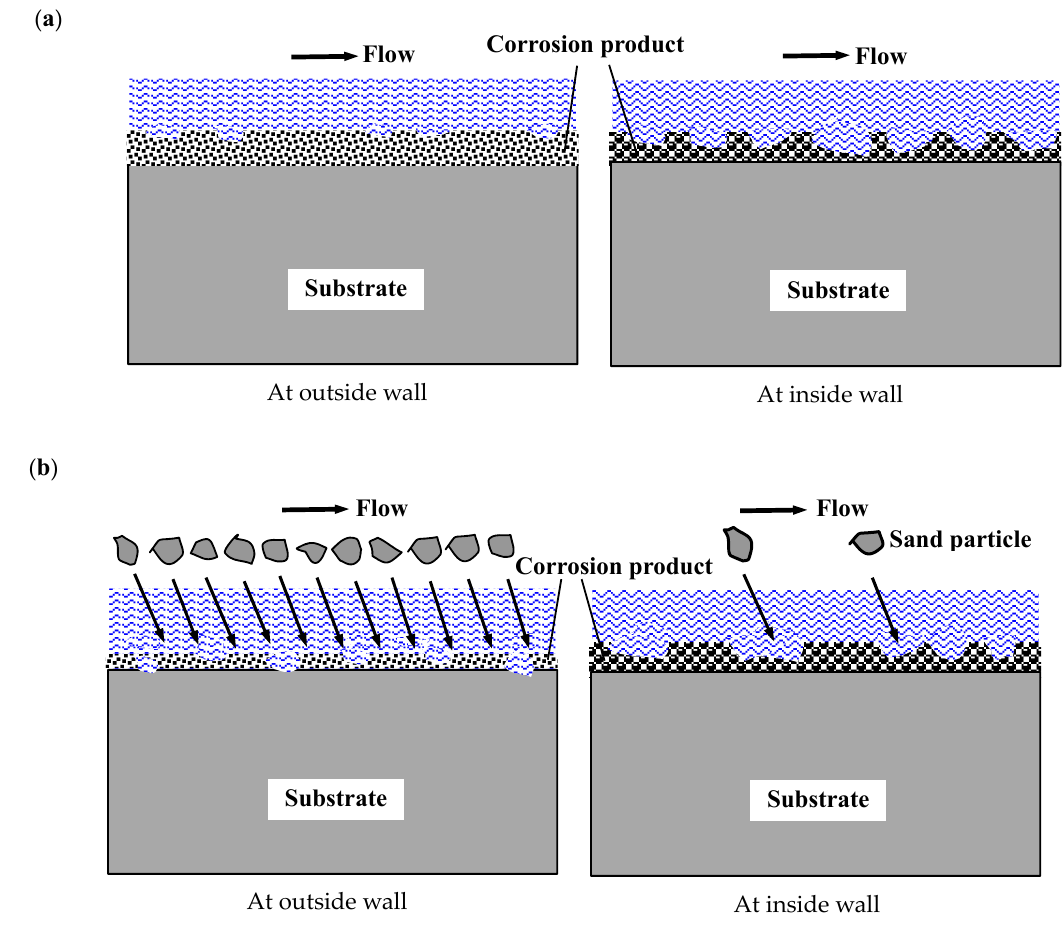
Figure 9. Schematic of the electrodes in different positions of the bend under flow conditions: ( a ) under FAC conditions; ( b ) under E-C conditions.